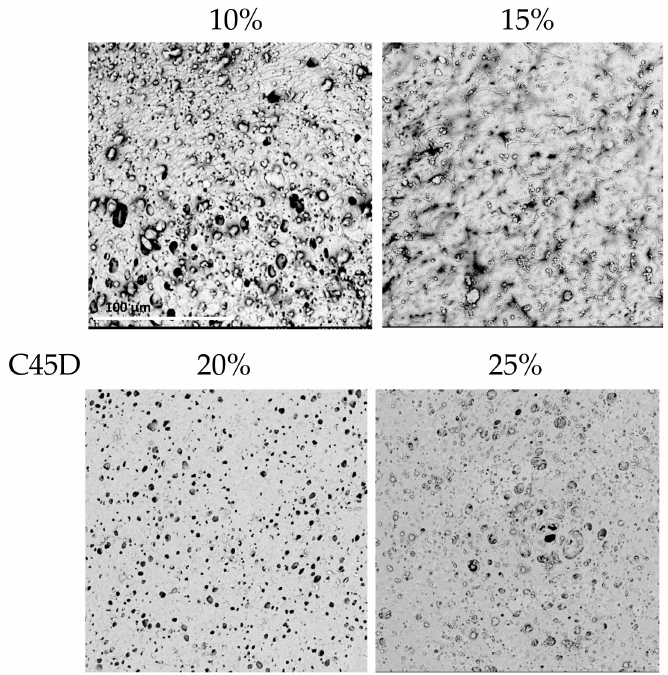
Figure 5. Morphology of internal surface of cylindrical scaffolds obtained from ChronoFlex C45D at different concentrations of polymer solution. For 15% PU only the outer surface was observed; scale bar: 100 µ m.